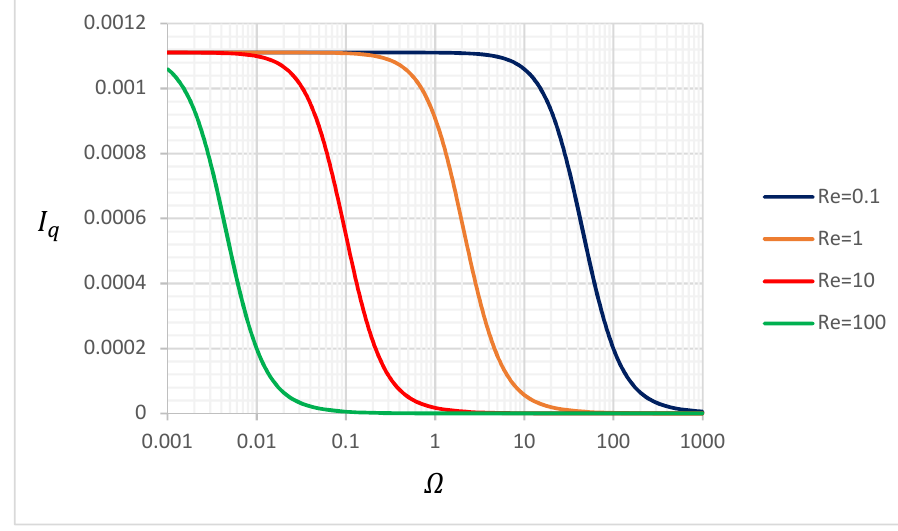
Figure 11. Dependency of the flow enhancement coefficient with dimensionless frequency and Reynolds number for n = 0.75 and ε = 0.1.